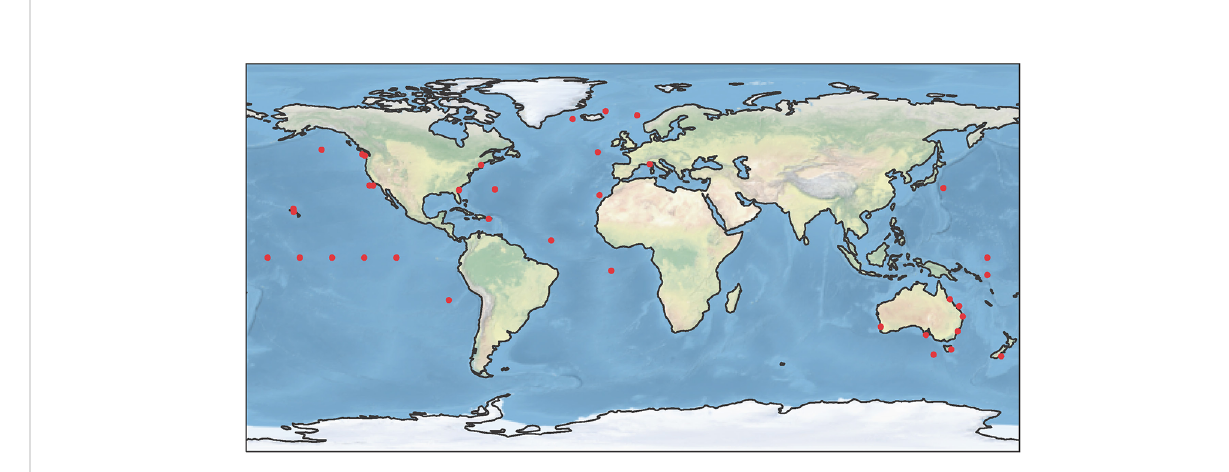
FIGURE 1 Locations of fi xed time series with active programs collecting ocean carbonate chemistry data on ships or moored buoys at sub-seasonal timescales and providing access to ≥ 10 years of publicly-available